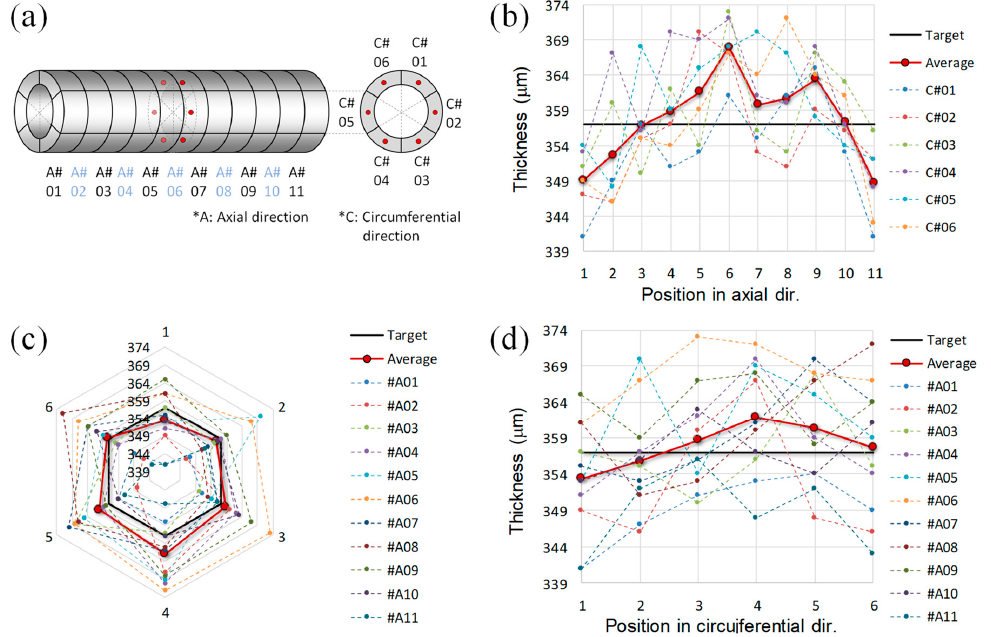
Figure 5. Analysis of thickness distribution. ( a ) denotation of subsection of composite tube, and measured thicknesses in the axial direction ( b ), and in the circumferential direction ( c , d ). In the circumferential direction, the average thicknesses in the axial direction for a given circumferential position range between 353.4 μ m ( C #01) to 361.9 μ m ( C #04), close to t avg_all , as shown